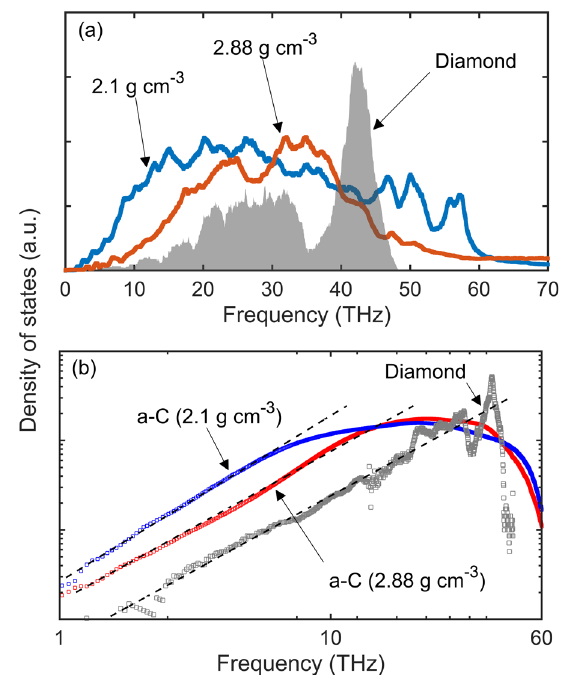
Fig. 3 Vibrational density of states of different carbon structures. a Characteristic vibrational density of states, D , showing calculations for high (2.88 g cm − 3 ) and low (2.1 g cm − 3 ) mass density cases for our amorphous carbon structures. For comparison, we also calculate D for a crystalline diamond domain. b Lattice dynamics calculated D for the two cases showing the ω 2 scaling at low frequencies. The straight line shows the fi t to a Debye model, which is applicable for long-wavelength phonons that propagate with velocities corre- sponding to the speed of sound in the solid. As the density of our structures decrease, the cutoff frequency where the Debye model is applicable shifts to lower frequencies. For comparison, we also include calculations of D for our crystalline diamond domain where the ω 2 scaling extends to higher frequencies as compared to the amorphous